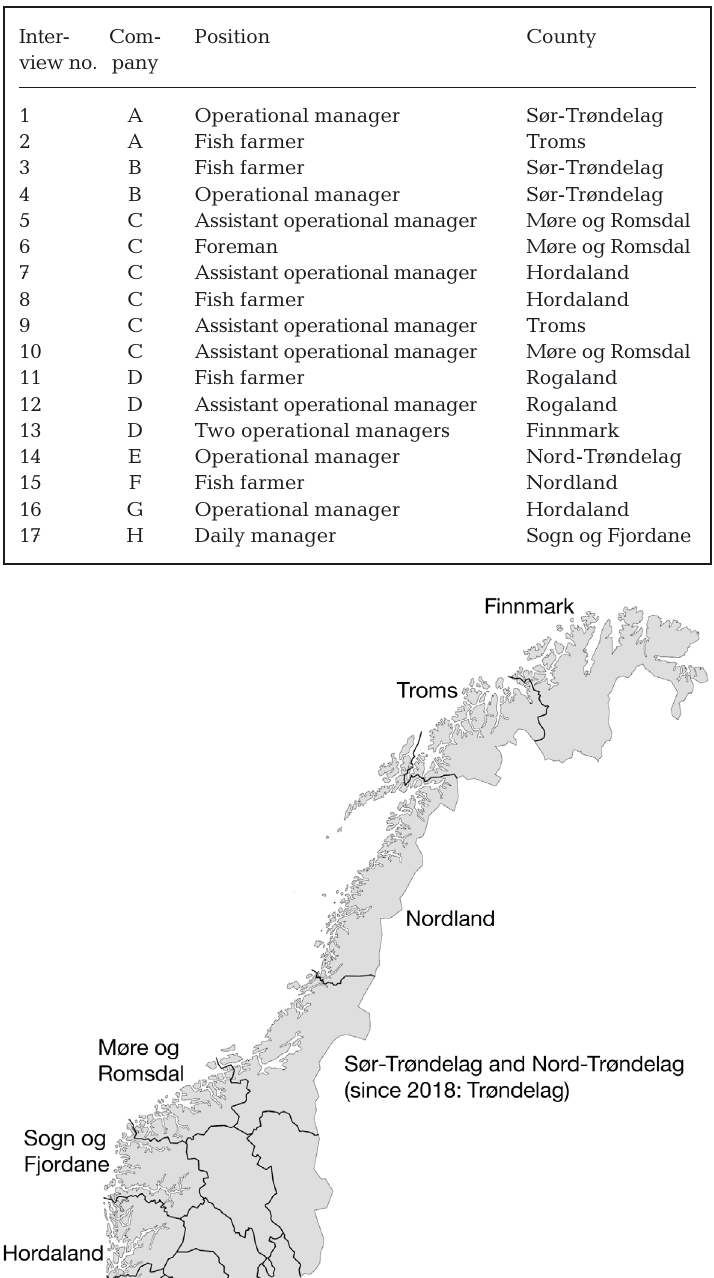
Table 1. List of participants from Norwegian salmon farms interviewed in 2017, sorted by company, position, and county